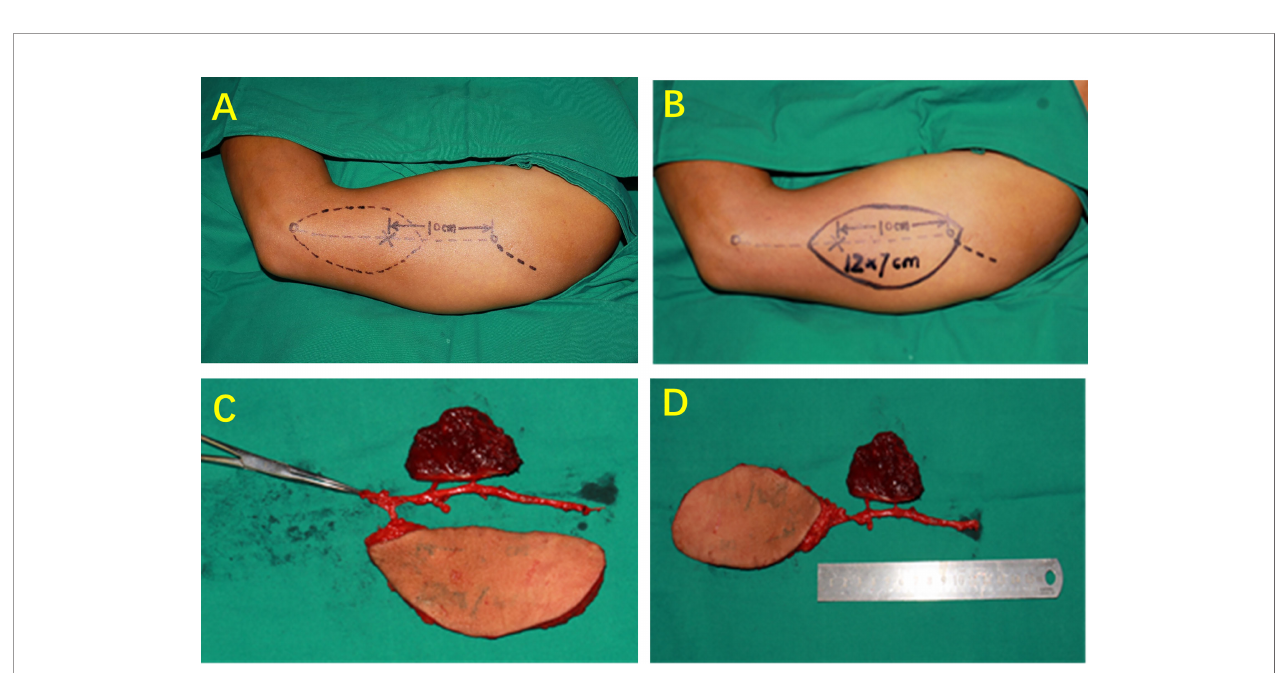
FIGURE 2 | Eccentric design, rotation repair perforated fl ap. (A) Schematic of traditional skin island design. (B) Schematic of eccentric design, rotation repair perforated fl ap design. (C) Before rotation, the pedicle length was 10 cm. (D) After rotation, the total length of the fl ap and vascular pedicle reached 24